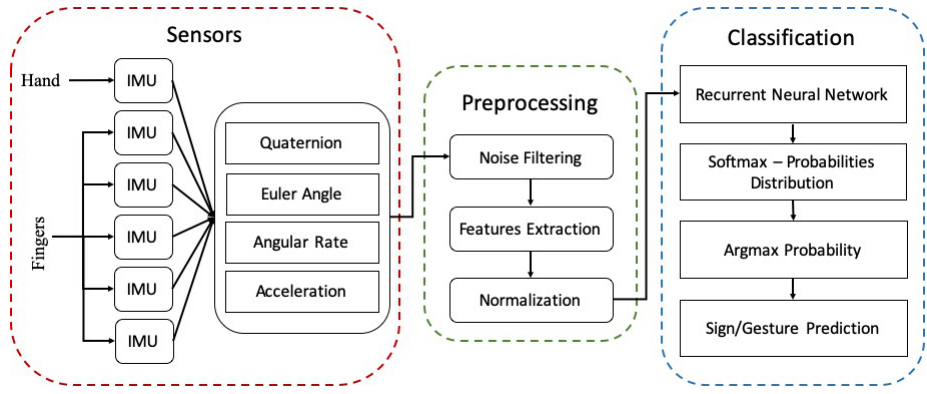
Figure 2. System overview of proposed smart wearable ASL recognition